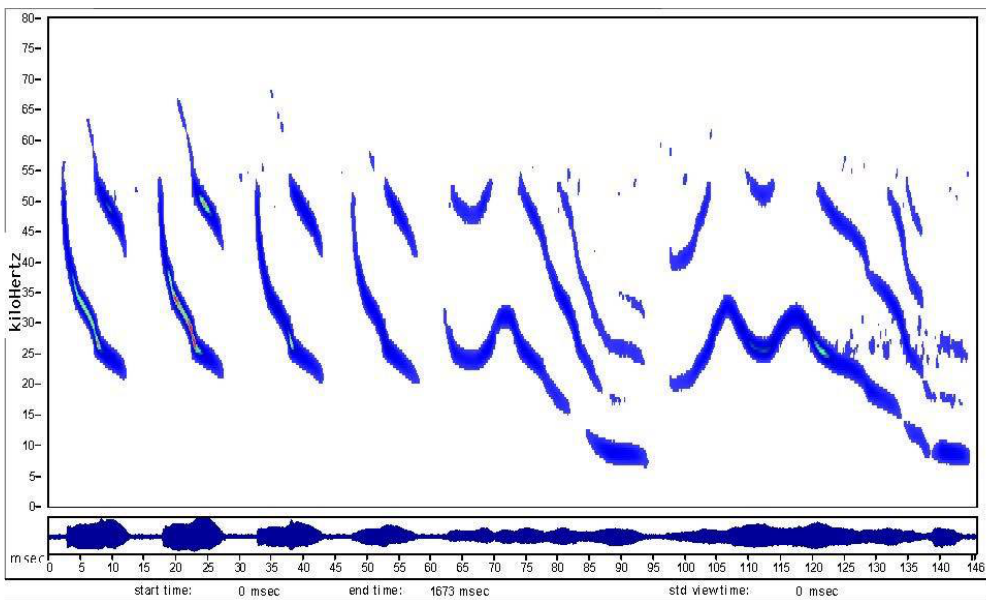
Figure 1. In this recording, the pallid bat (Antrozous pallidus) makes four echolocation calls fol- lowed by social calls. The spectrogram above (kHz vs. msec) is a graphic representation of the spectrogram above (kHz vs. msec) is a graphic representation of the sounds. Credit: Katy Warner, Colorado State sounds. Credit: Katy Warner, Colorado State Univ.